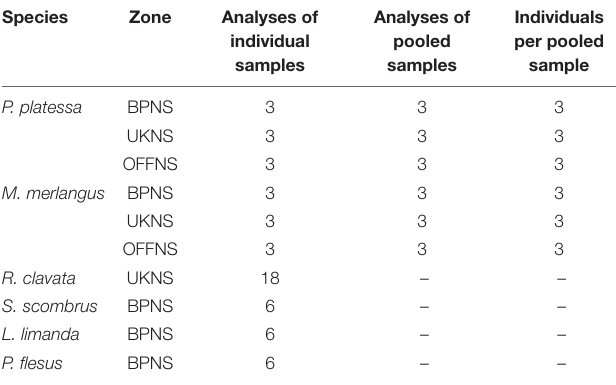
TABLE 3 | Sample processing scheme for fish GIT analysis (n: sample size, i.e., number of